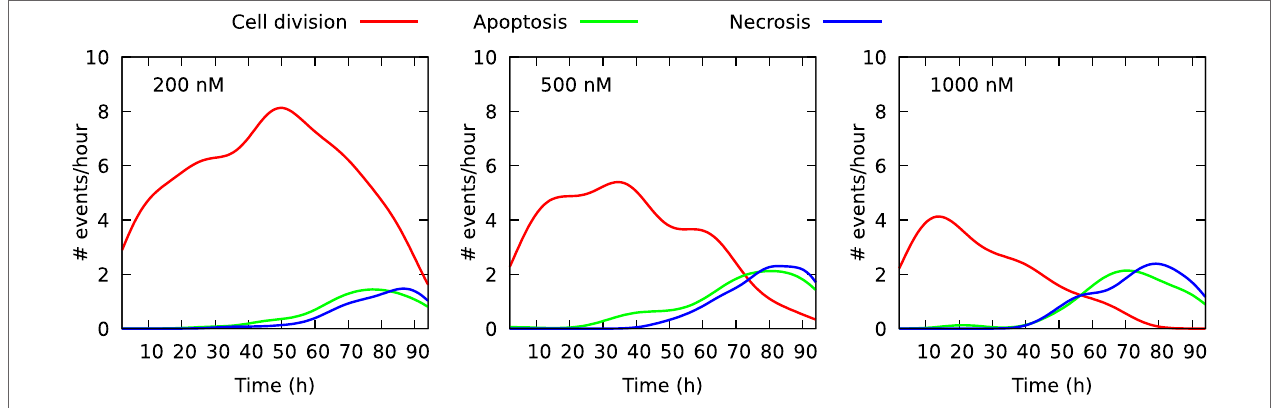
FigUre 3 | Frequency of cell division and cell death in three cell populations of initial size 100 individuals. The cells were exposed to YTX at concentrations 200, 500, and 1,000 nM. These data result from individual cell tracking. Note that cells start to die at about 40 h after exposure except for 500 nM where apoptosis-like cell death starts to appear after 20 h. Many cells exposed to 1,000 nM enter quiescence after range 30–40 h (see also Figures 6 – 8 below).